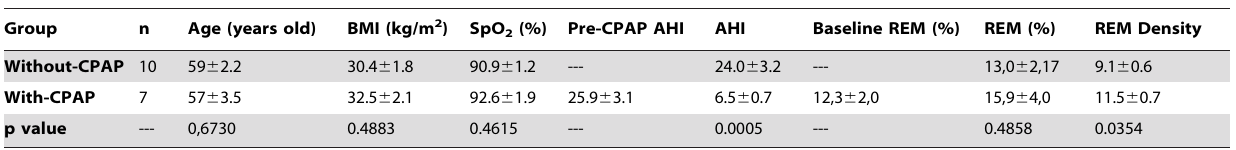
Table 2. Demographic and polysomnographic variables in all subjects.